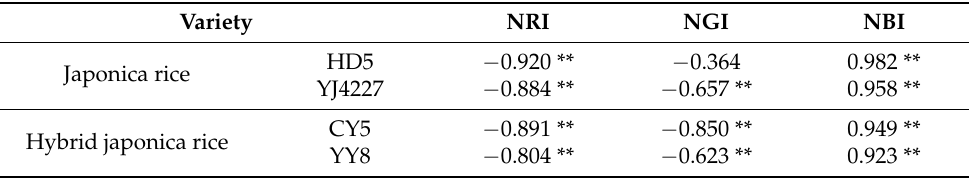
Table 9. Correlation coefficients between the color indices of rice leaves and the nitrogen contents of leaves after anthesis.